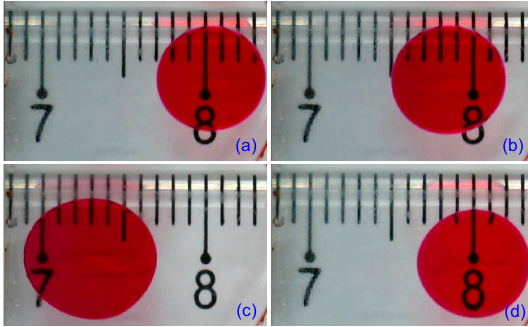
Figure 5. The motion of the droplet impacted with different voltages. ( a ) V = 0, ( b ) V = 40 V rms , ( c ) V = 50 V rms , and ( d ) after removing the voltage for 17